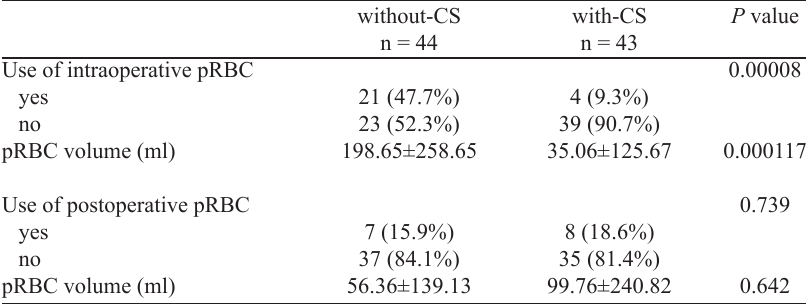
Table 2. Necessity of intra and postoperative packed red blood cells in both